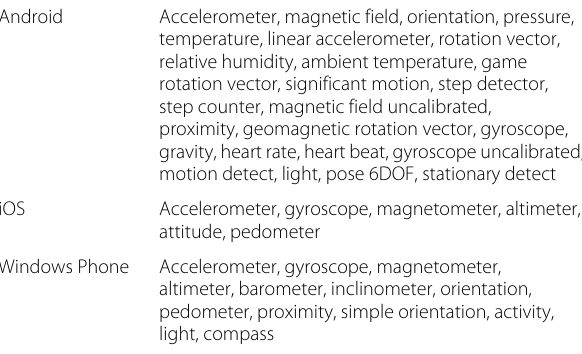
Table 1 Sensors supported by different mobile platforms